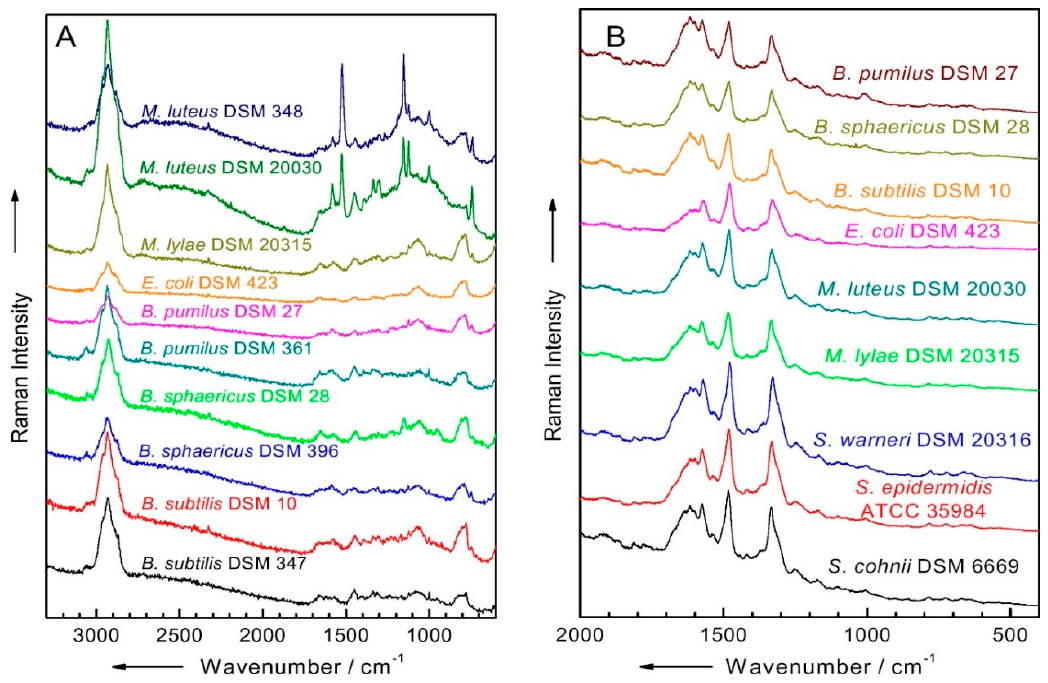
Figure 7. ( A ) Characterizing single microbial cells using micro-Raman spectra at 532 nm excitation. ( B ) Bulk microbial samples (up to 6 log cells) using ultraviolet-resonance Raman spectra excited at 257 nm (Adopted and reproduced from Popp [60] with permission from SPIE publication).